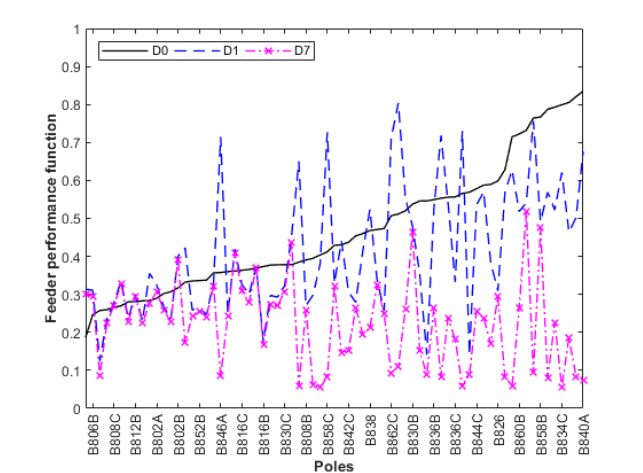
Figure 23. D function evaluation for Case 3 with m = 0.5 and n = 0.5, including the base case (D0); lightning arresters at only the transformer’s pole (D1); and lightning arresters at the transformer’s pole and at the six most critical poles (D7).